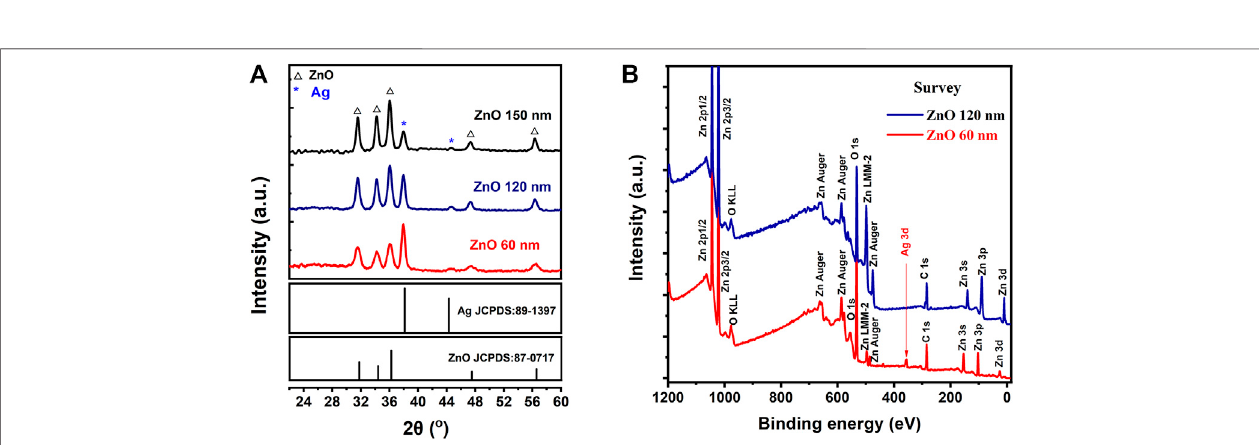
Frontiers in Chemistry |